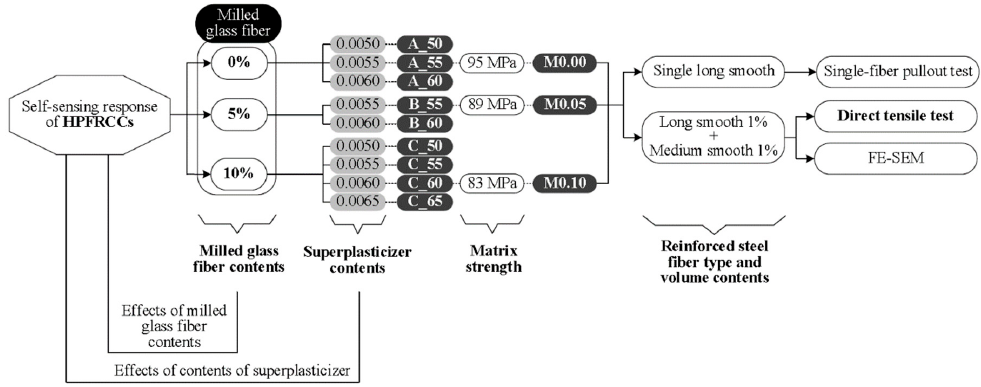
Figure 3. Experimental program. Table 1. Matrix composition by weight ratio and properties.